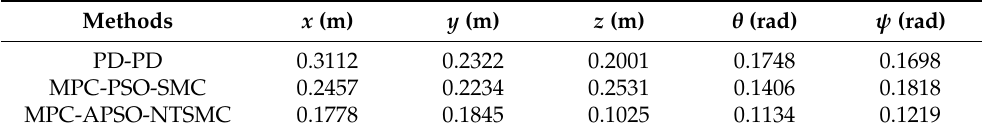
Figure 24. Velocity tracking for the AUV without disturbance for Case 2. Table 6. Position MAE without disturbance after 20 s for Case 2.